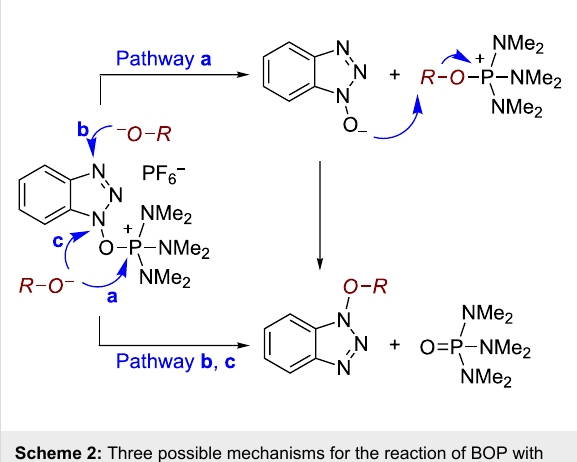
Scheme 2: Three possible mechanisms for the reaction of BOP with oxygen